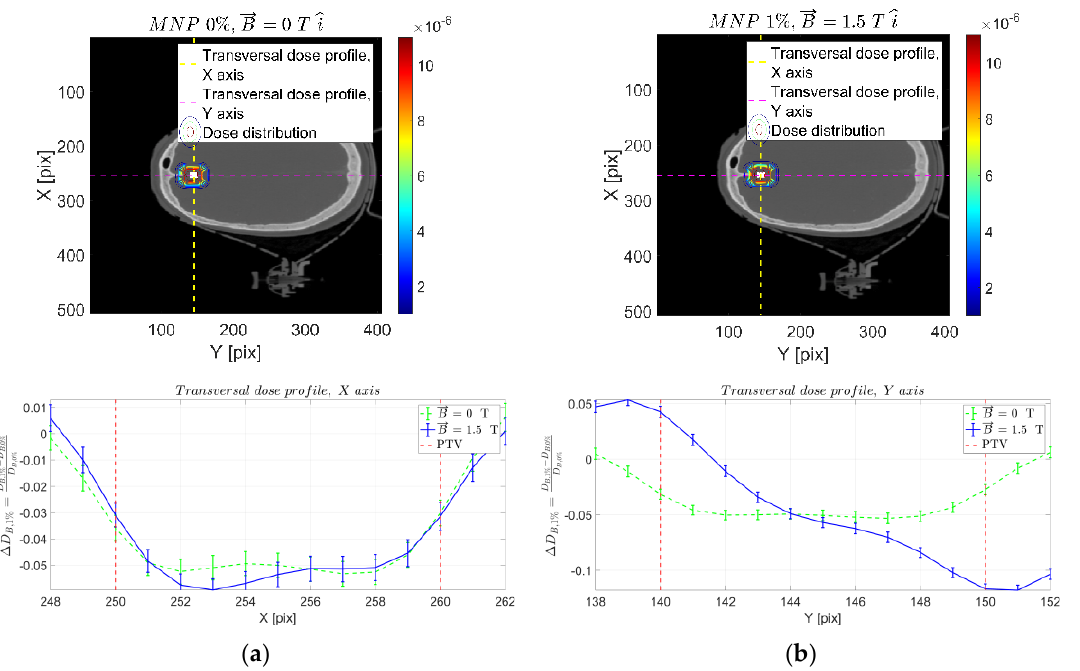
Figure 4 shows a representative dose distribution example, reporting the transversal dose map for the 1% w / w and 1.5 T in the x ‐ axis direction (1 ‐ 1.5x) and reference cases along with the corresponding dose profiles within a region of interest (ROI) around the MNP ‐ infused target.